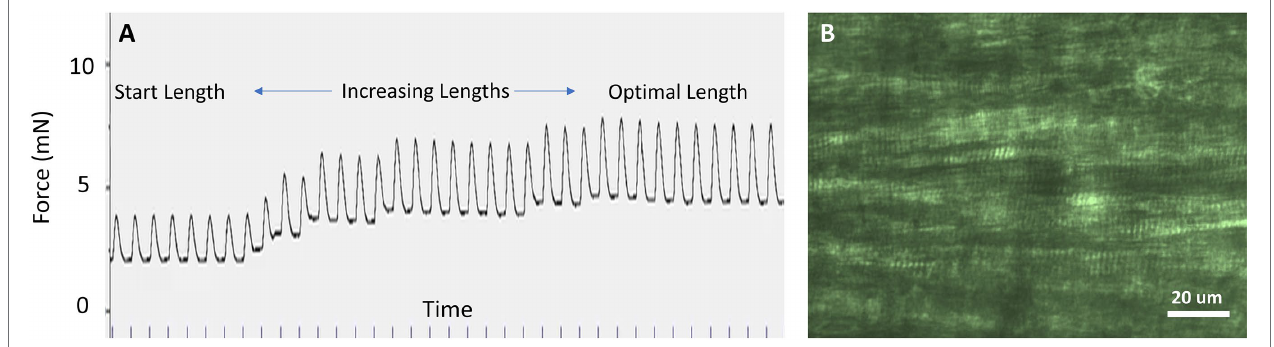
FIGURE 6 | Starting muscle length. (A) When sarcomeres are not visible, the optimal muscle length can be determined by lengthening the muscle until the peak twitch force (systolic minus diastolic force) is maximized while the diastolic force is minimized. In this example, stimulation was repeated at 1 Hz. (B) In cardiac slices of ~0.2 mm thickness, sarcomeres are clearly visible using light microscopy and can be used to adjust sarcomere length. In this example, sarcomere length is 2.0 μ m.